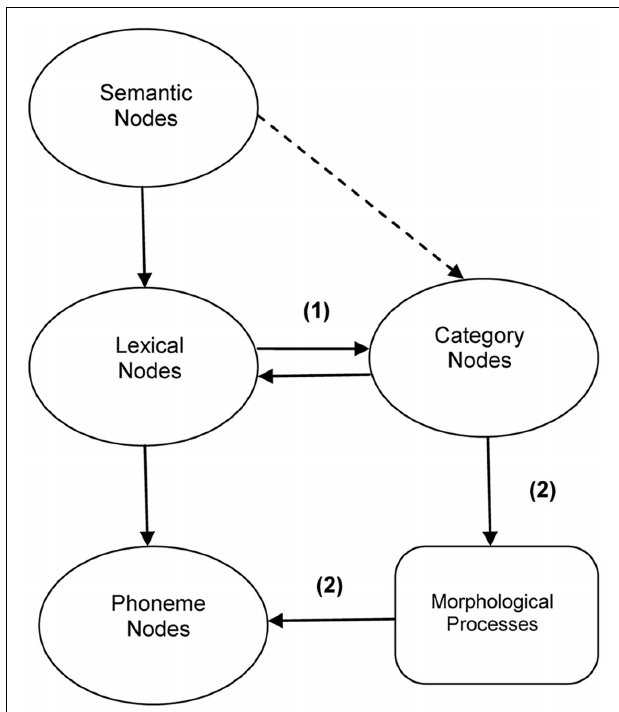
FIGURE 2 |A schematic representation of two hypothetical mechanisms allowing grammatical category information to impact word retrieval processes: (1) Bidirectional links between lexical and grammatical category nodes; (2) Priming of category-specific morphological